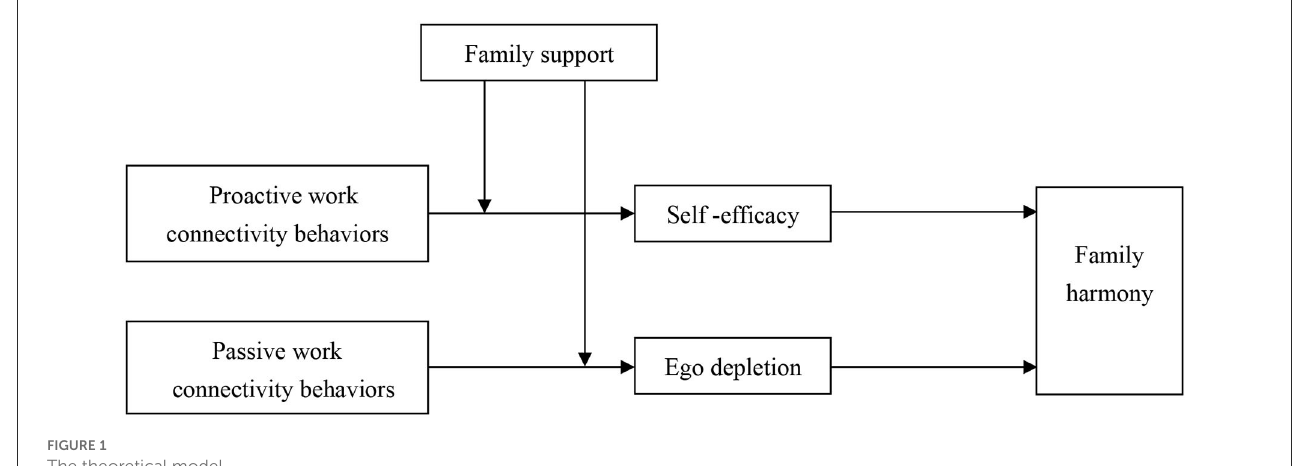
FIGURE1 The theoretical model.